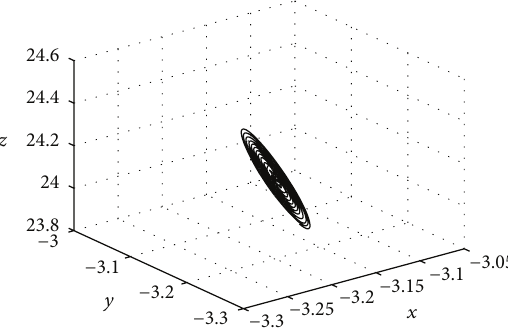
Figure 7: A Hopf bifurcation occurs at the steady state 𝑆 − of system (4) when 𝑏 1 = 𝑏 𝑐 .